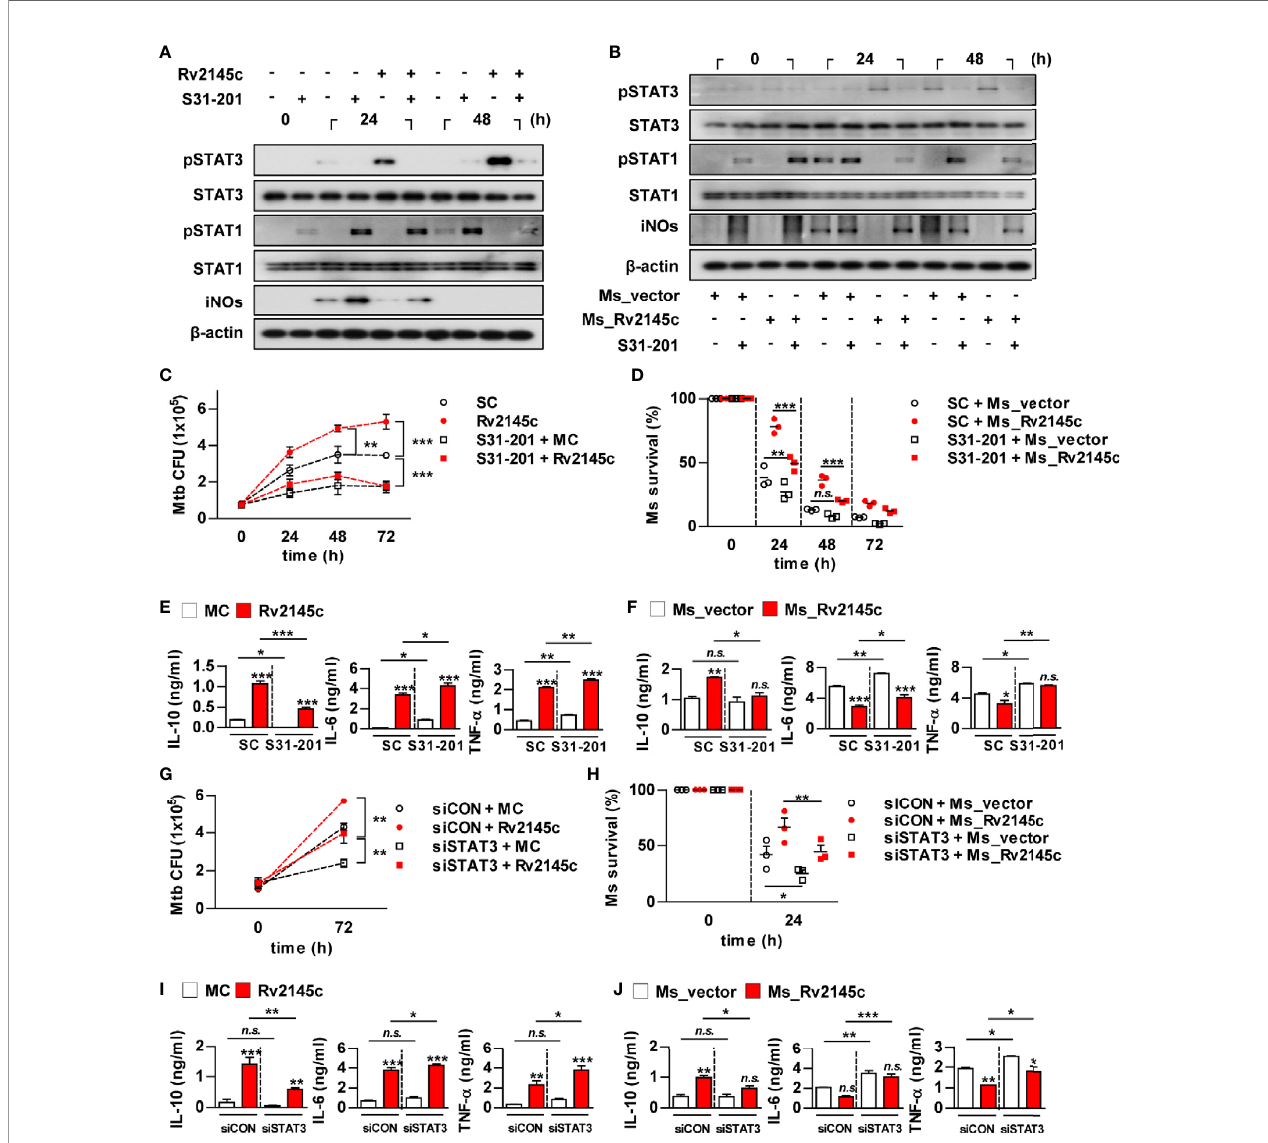
FIGURE 6 | STAT3 signaling is important for Rv2145c-mediated intracellular survival and IL-10 production. (A-F) BMDMs pretreated with pharmacological inhibitors of STAT3 (S31-201, 5 m M) for 1 h were infected with (A, C, E) Mtb at an MOI of 1 for 4 h and treated with 10 m g/ml Rv2145c or (B, D, F) Ms_vector or Ms_Rv2145c at an MOI of 10 for 4 h. Then, the cells were cultured in the presence and absence of S31-201 for the indicated times. (A, B) Total cell lysates were separated by SDS – PAGE, followed by immunoblot analysis using antibodies against phospho-STAT3, STAT3, phospho-STAT1, STAT1, iNOs and b -actin. This image is representative of three experiments showing similar results. (C, D) Bacterial CFUs were determined at the indicated times. (E, F) IL-10, IL-6, and TNF- a levels in the culture supernatants at 72 h (E) or 24 h (F) were measured by ELISA. (G – J) BMDMs were transfected with STAT3 siRNA (siSTAT3) or non-speci fi c siRNA as a control (siCON) and were infected with (G, I) Mtb at an MOI of 1 for 4 h, and incubated with 10 m g/ml Rv2145c or (H, J) Ms_vector or Ms_Rv2145c at an MOI of 10 for 4 h, incubated for the indicated times. (G, H) Intracellular bacterial growth was determined by plating the cell lysates on 7H10 agar. (I, J) IL-10,